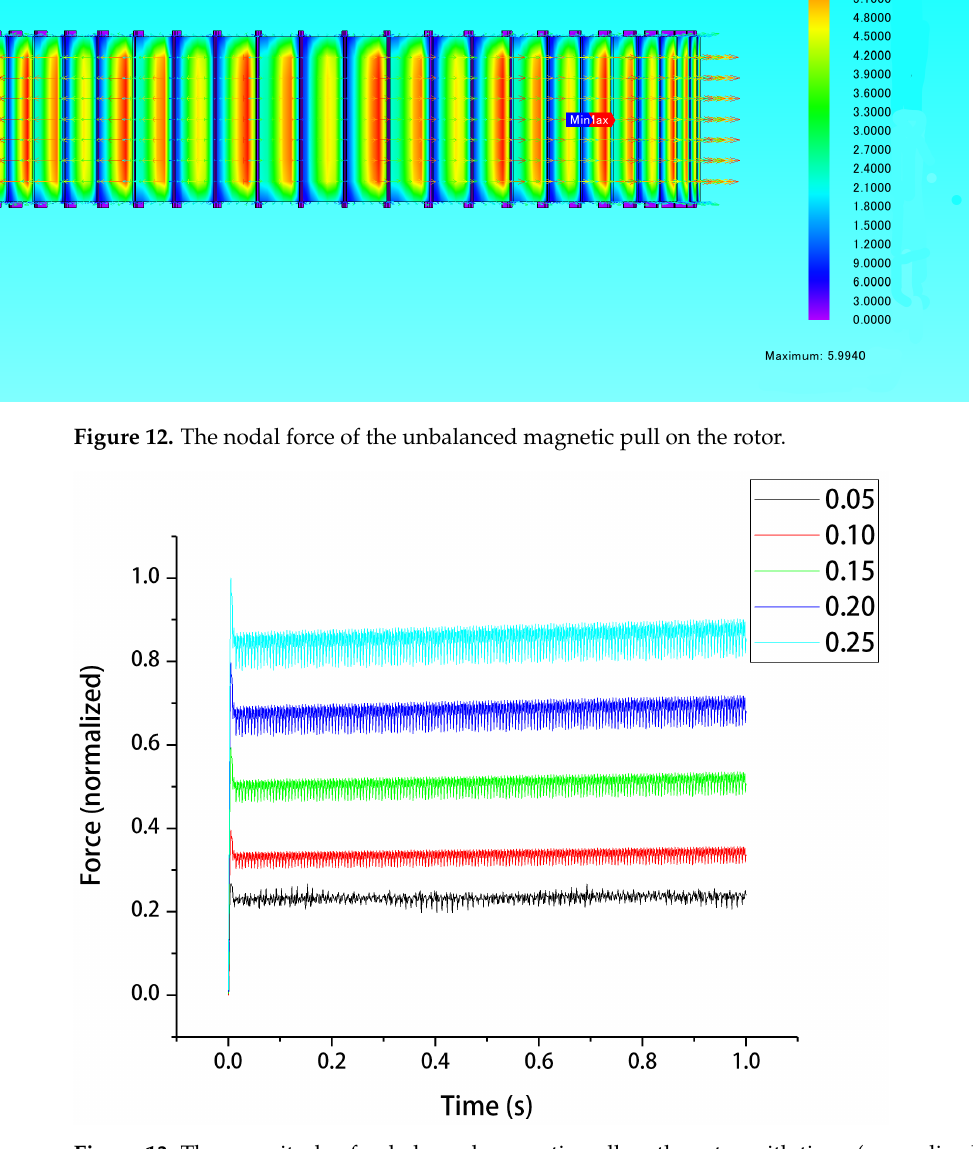
Figure 13. The magnitude of unbalanced magnetic pull on the rotor with time.